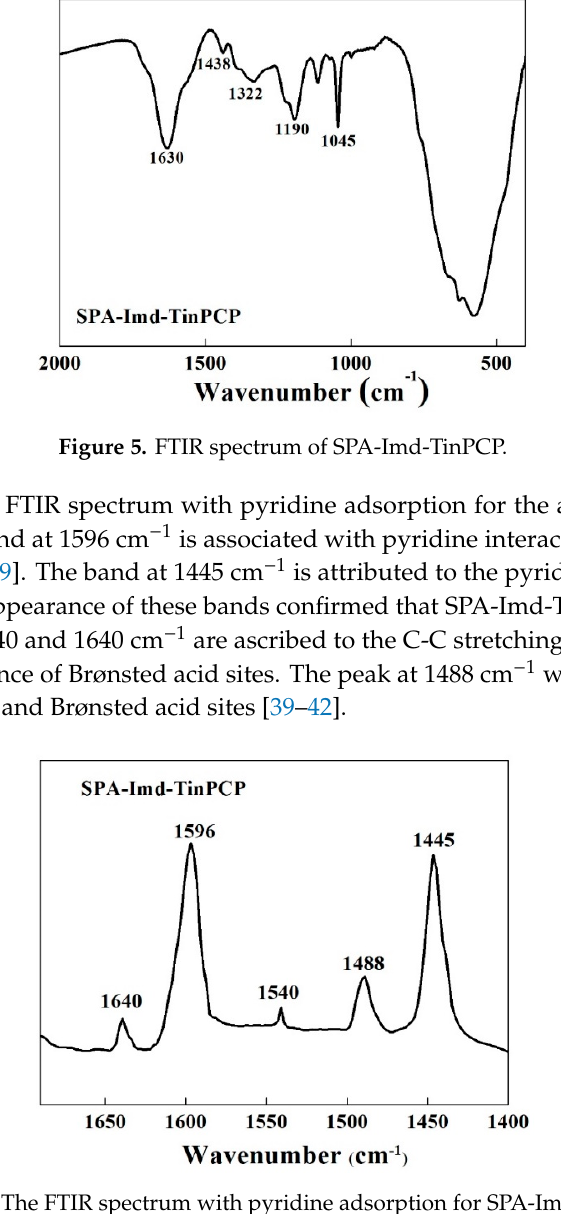
Figure 6. The FTIR spectrum with pyridine adsorption for SPA-Imd-TinPCP.